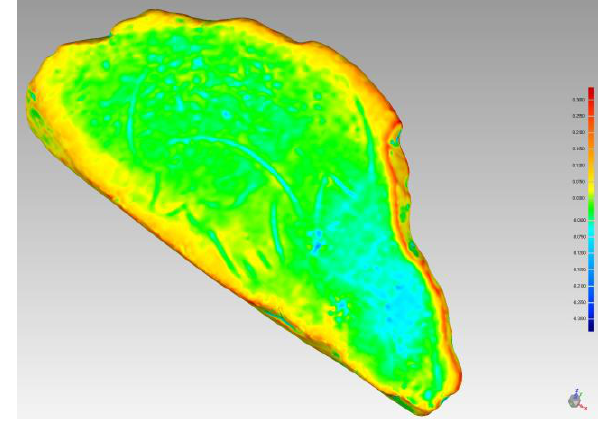
Figure 9: Results on the Nylon PA 12